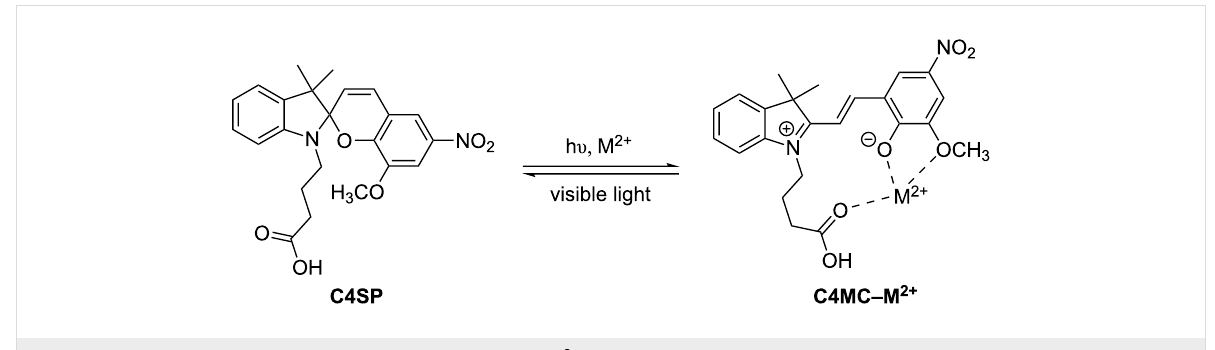
Scheme 1: C4SP–C4MC spiropyran-merocyanine equilibrium and M 2+ binding.